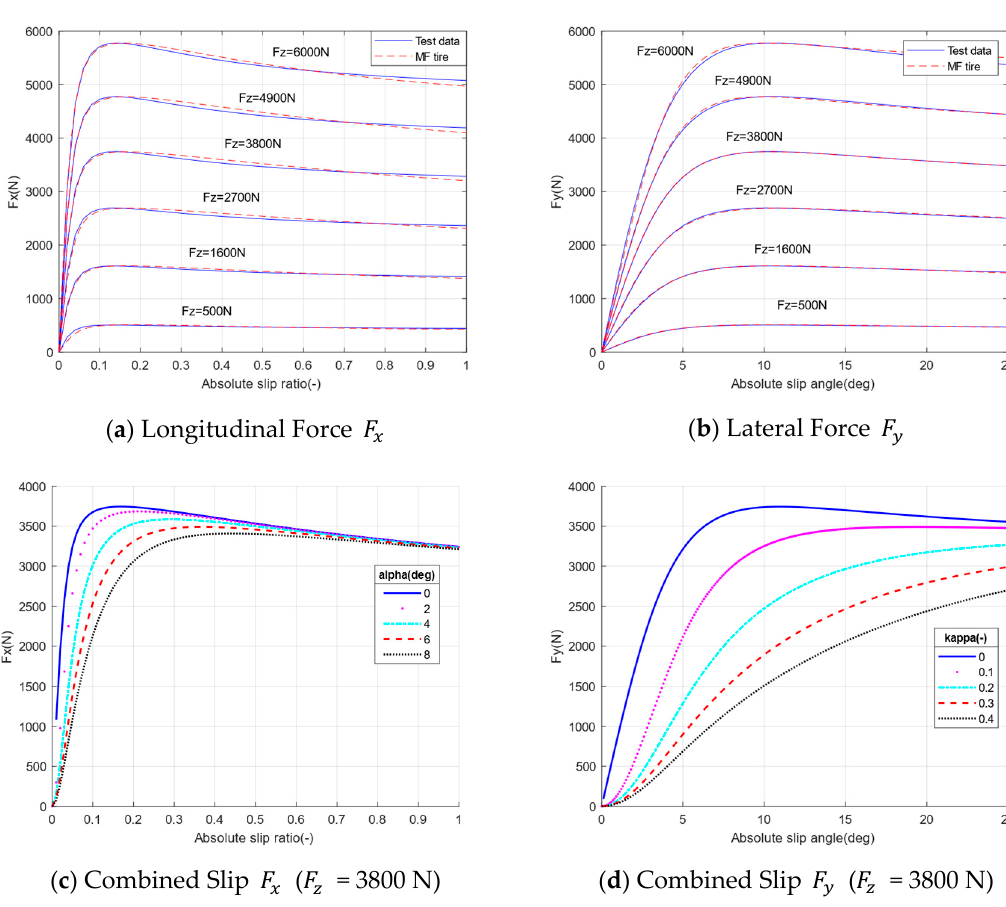
Figure 1. Pacejka tire model. ( a ) Fitting results, longitudinal force; ( b ) Fitting results, longitudinal force; and ( c , d ) Combined slip characteristic under 3800 N vertical load.